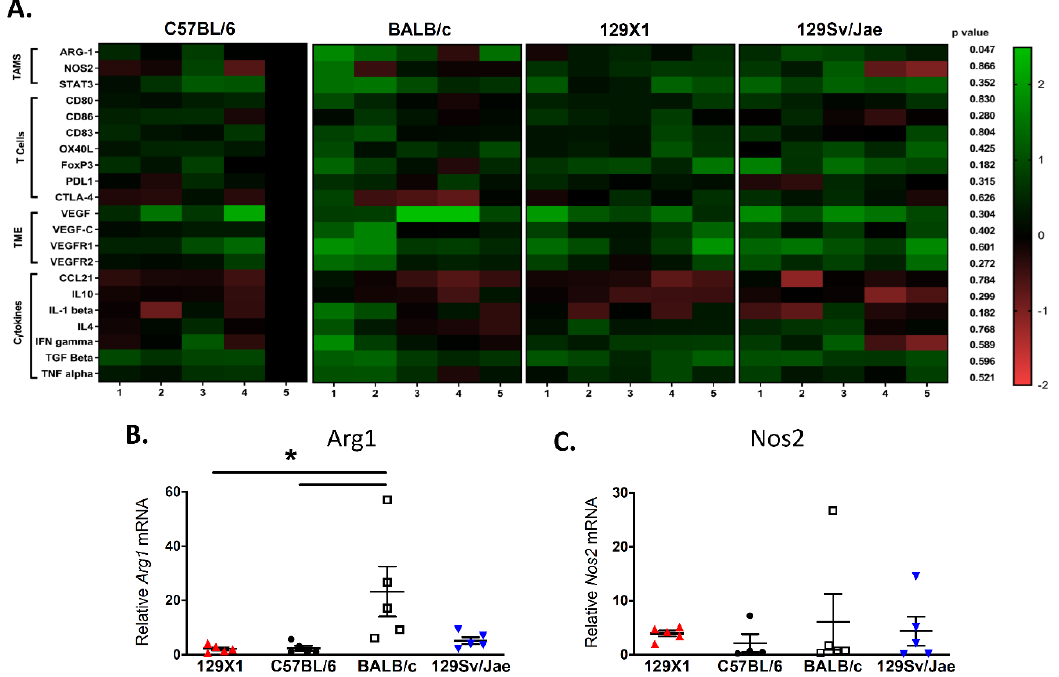
Figure 4. Expression of key genes in the MPNST microenvironment. ( A ) RT-qPCR analysis of markers for innate immunity, adaptive immunity, angiogenesis, and cytokine signaling in terminally-harvested tumors shows a large degree of heterogeneity between host strains and individual tumors. Samples are normalized to a single C57BL/6 tumor, shown as reference ( n = 5 tumors per strain). ( B ) Expression analysis determines that MPNSTs from BALB/c mice express significantly higher levels of Arg-1 mRNA, a marker of immunosuppressive M2 macrophages, when compared to tumors from 129/SvJae, C57BL/6, and 129X1 mice. ( C ) In contrast, levels of Nos2 mRNA, a marker of M1 macrophages, is similar in tumors from all background strains. 129X1 (red circles), C57BL/6 (black triangles), BABL/c (white squares), and 129/SvJae (blue triangles). Analyzed by one-way ANOVA with Tukey’s multiple comparison test. A p -value of less than 0.05 is considered statistically significant and is denoted by “*”.